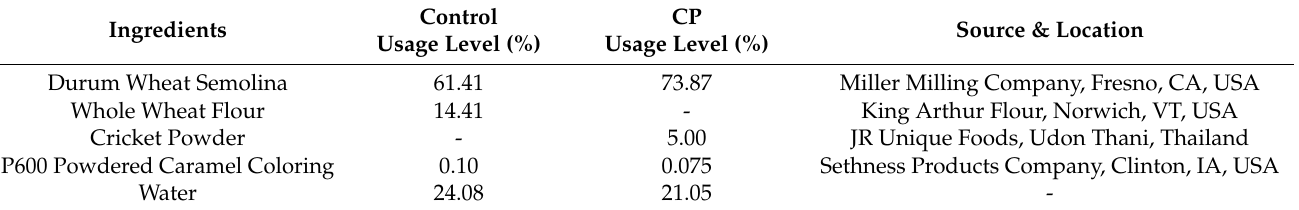
Table 2. The usage levels of the ingredients used for the pasta with NO cricket powder (Control) and pasta containing cricket powder (CP). All percentages (except caramel coloring) were rounded to the nearest hundredth place.